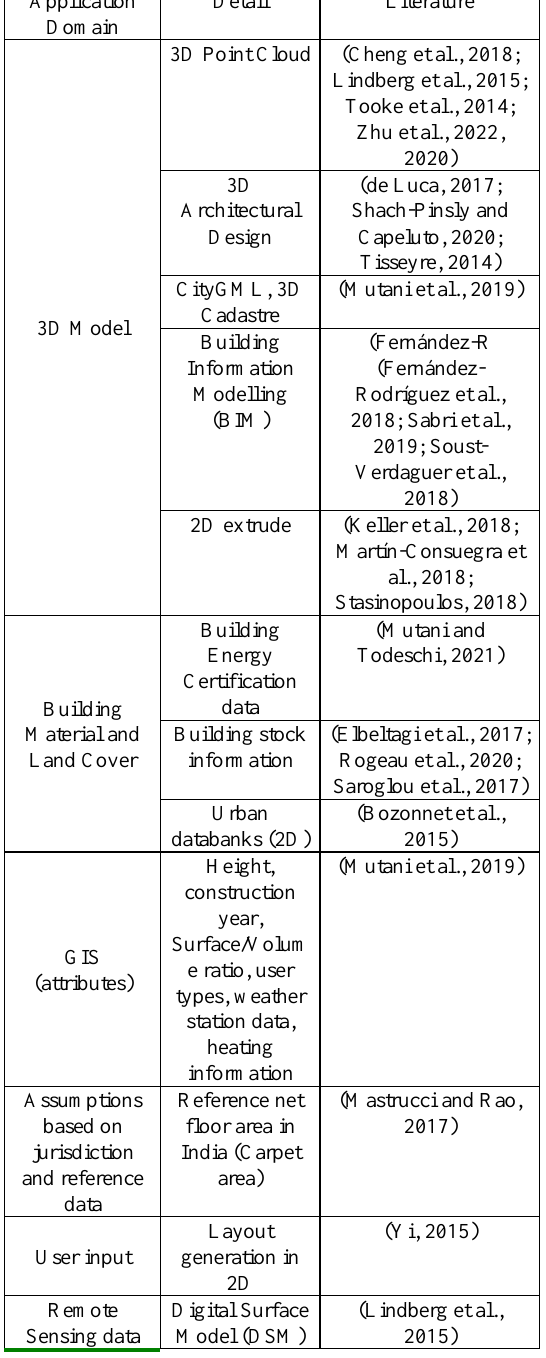
Table 3 . Spatial and 3D data types that used for the city and building models in urban